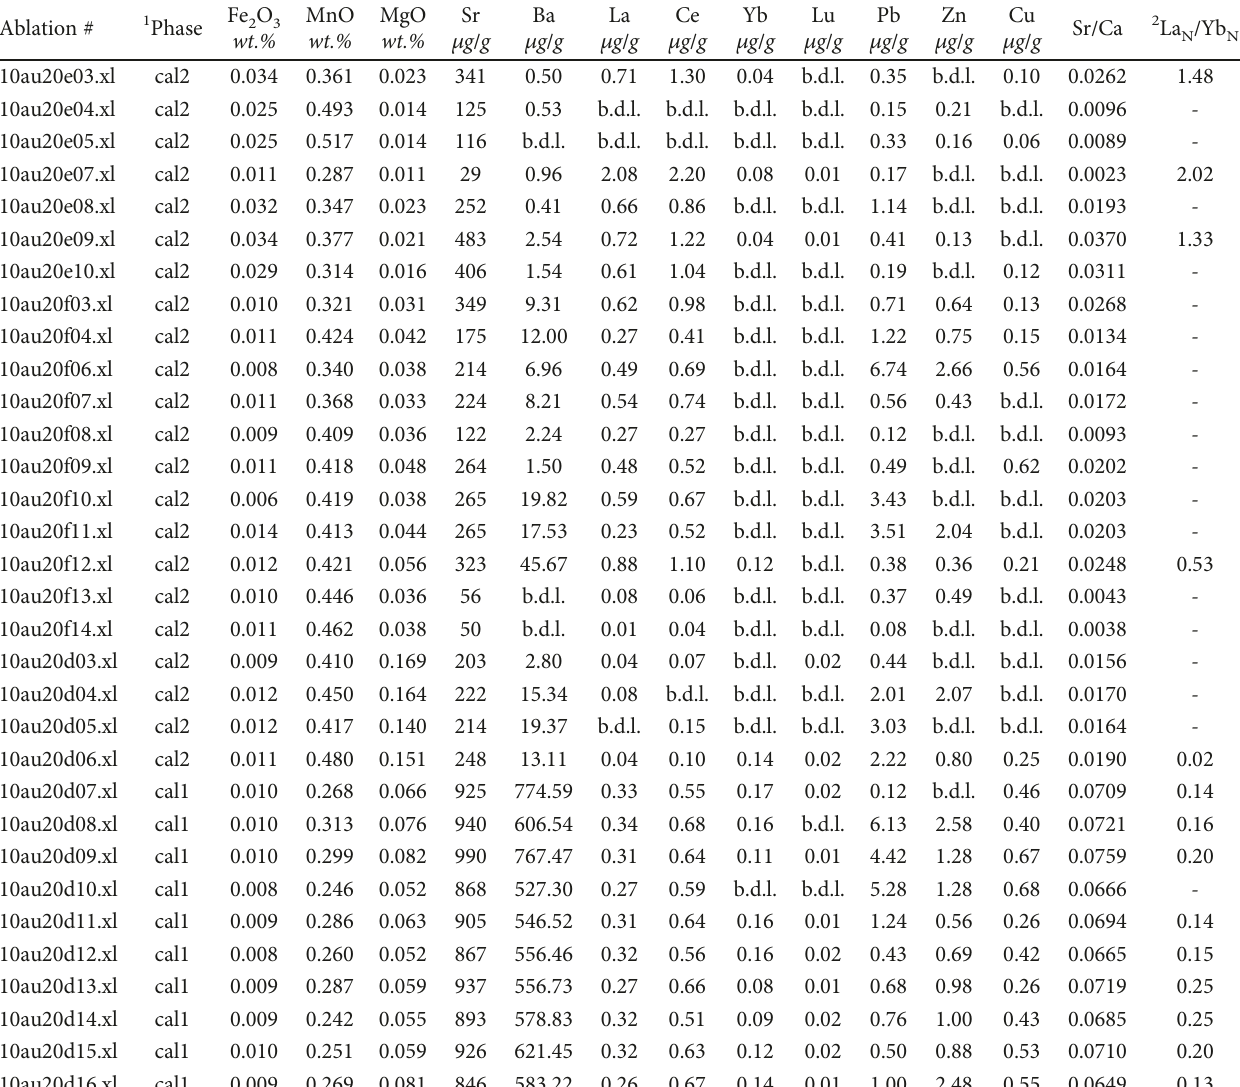
Table 3: Selected trace element concentrations from paleospring